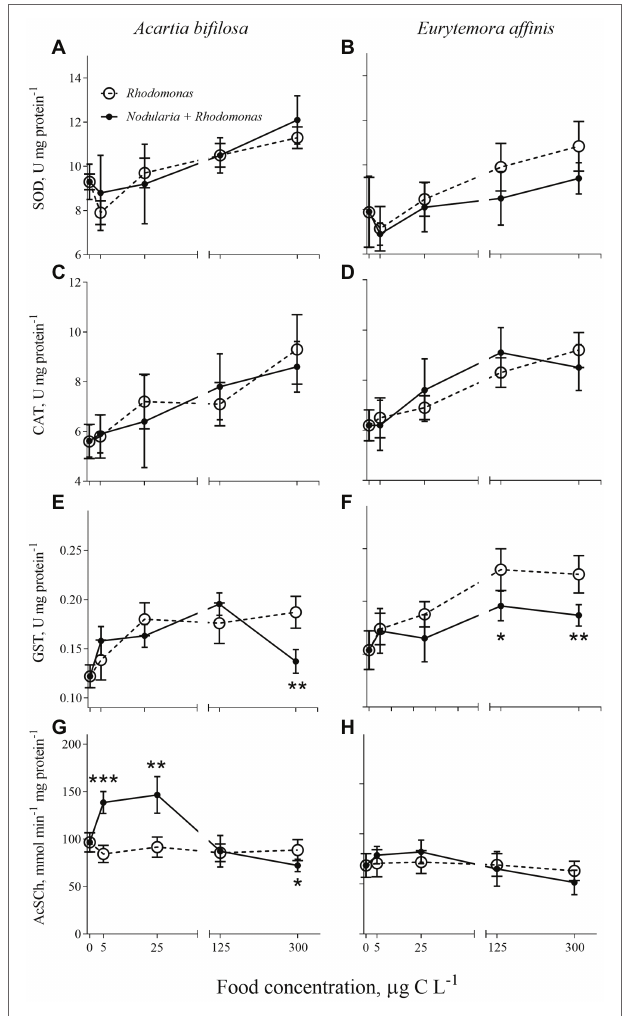
FIGURE 1 | Acartia bifilosa (A,C,E,G) and Eurytemora affinis (B,D,F,H) : effects of diet (mixed Rhodomonas salina and Nodularia spumigena vs. R. salina ) and food concentration (0–300 μ g C L − 1 ) on enzyme activities: (A,B) superoxide dismutases, SOD, U mg protein − 1 ; (C,D) catalases, CAT, U mg protein − 1 ; (E,F) glutathione S-transferases, GST, U mg protein − 1 ; and (G,H) acetylcholinesterase (AChE) activity, nmol AcSC min − 1 mg protein − 1 . The data are presented as mean ± SD ( n = 5 in all cases); * p < 0.05, ** p < 0.01, *** p < 0.001 when compared to the respective nontoxic control.